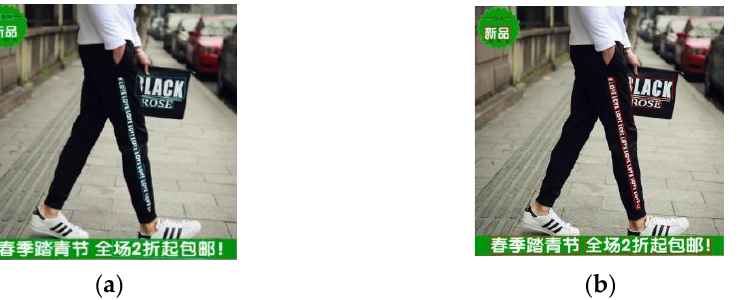
Figure 5. Comparison of text detection effect with or without adding BLSTM network. ( a ) Test result without BLSTM network; ( b ) Test result with BLSTM network.